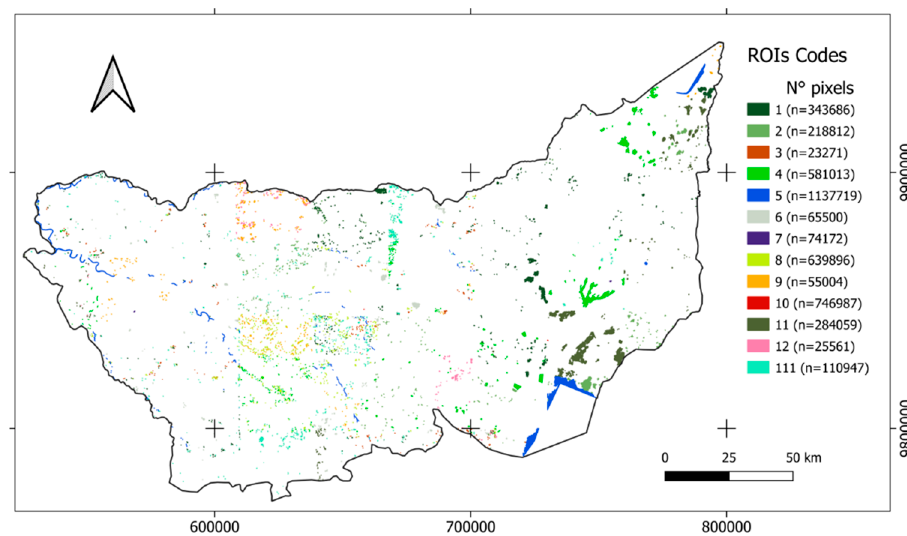
Figure 6. Locations and number of pixels of ROIs (Reference Frame: WGS84/UTM35S).